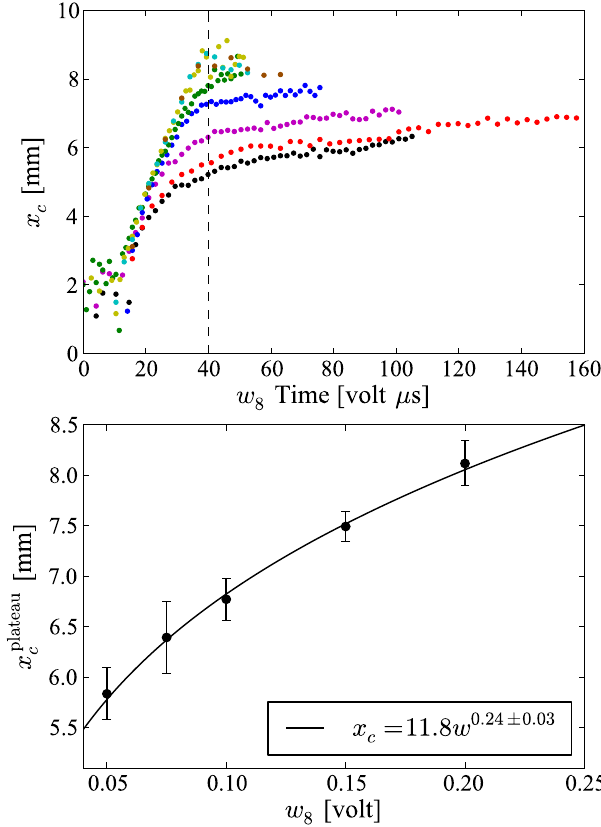
FIG. 11. The upper part of the figure shows the time evolution of the centroid amplitude calculated from ion loss data using Eq. (11). The measured size of the plasma distribution σ is 1.43 mm. The x measured maximum centroid values are given by the mean of the centroid data from 40 V μ s onwards, shown in the lower figure (black dots) together with the power law fit (solid black